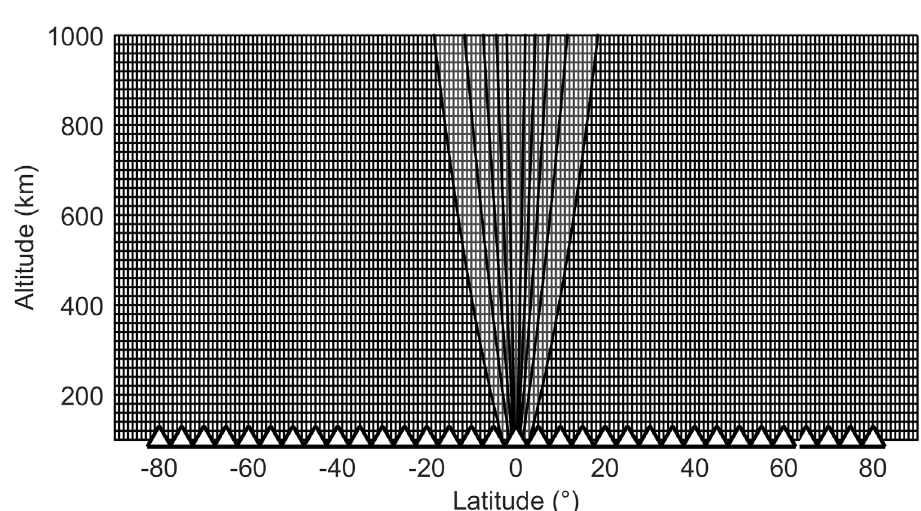
Figure 1 - Ionospheric grid with a spatial resolution of 1° x 20 km in latitude by altitude, virtual receivers located at every 5° (triangles) and the coverage area of the simulated GNSS signals for one receiver.